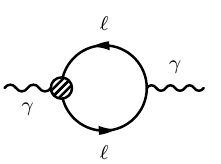
Figure 4 . Eight largest scales probed by the anomalous magnetic moments of the muon (orange) and the electron (blue) of the LEFT Wilson coefficients in eq. (4.1), illustrated for the choices c ( c ) = − c T = 1 and ∆ a Cs based on the Cesium input for α QED . For the dipole-operator coefficients, e T we assume the SMEFT scaling L ∼ v/ Λ 2 . eγ